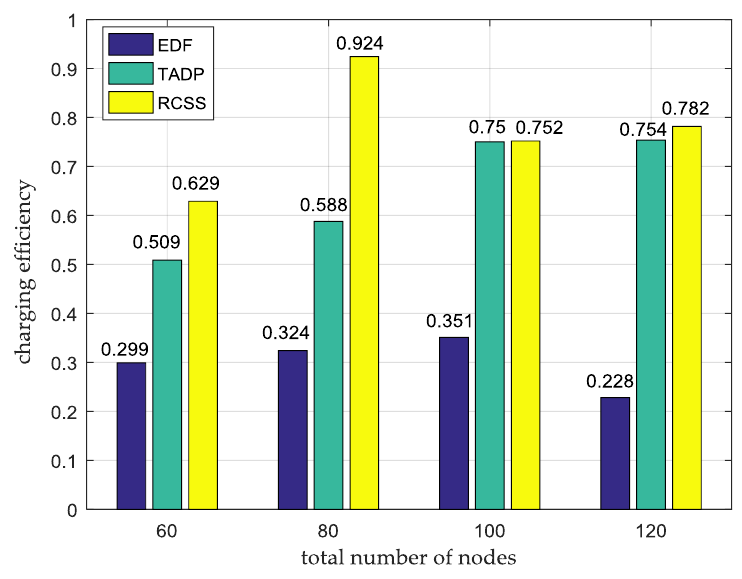
Figure 6. The comparison of charging efficiency among RCSS, TADP and EDF.